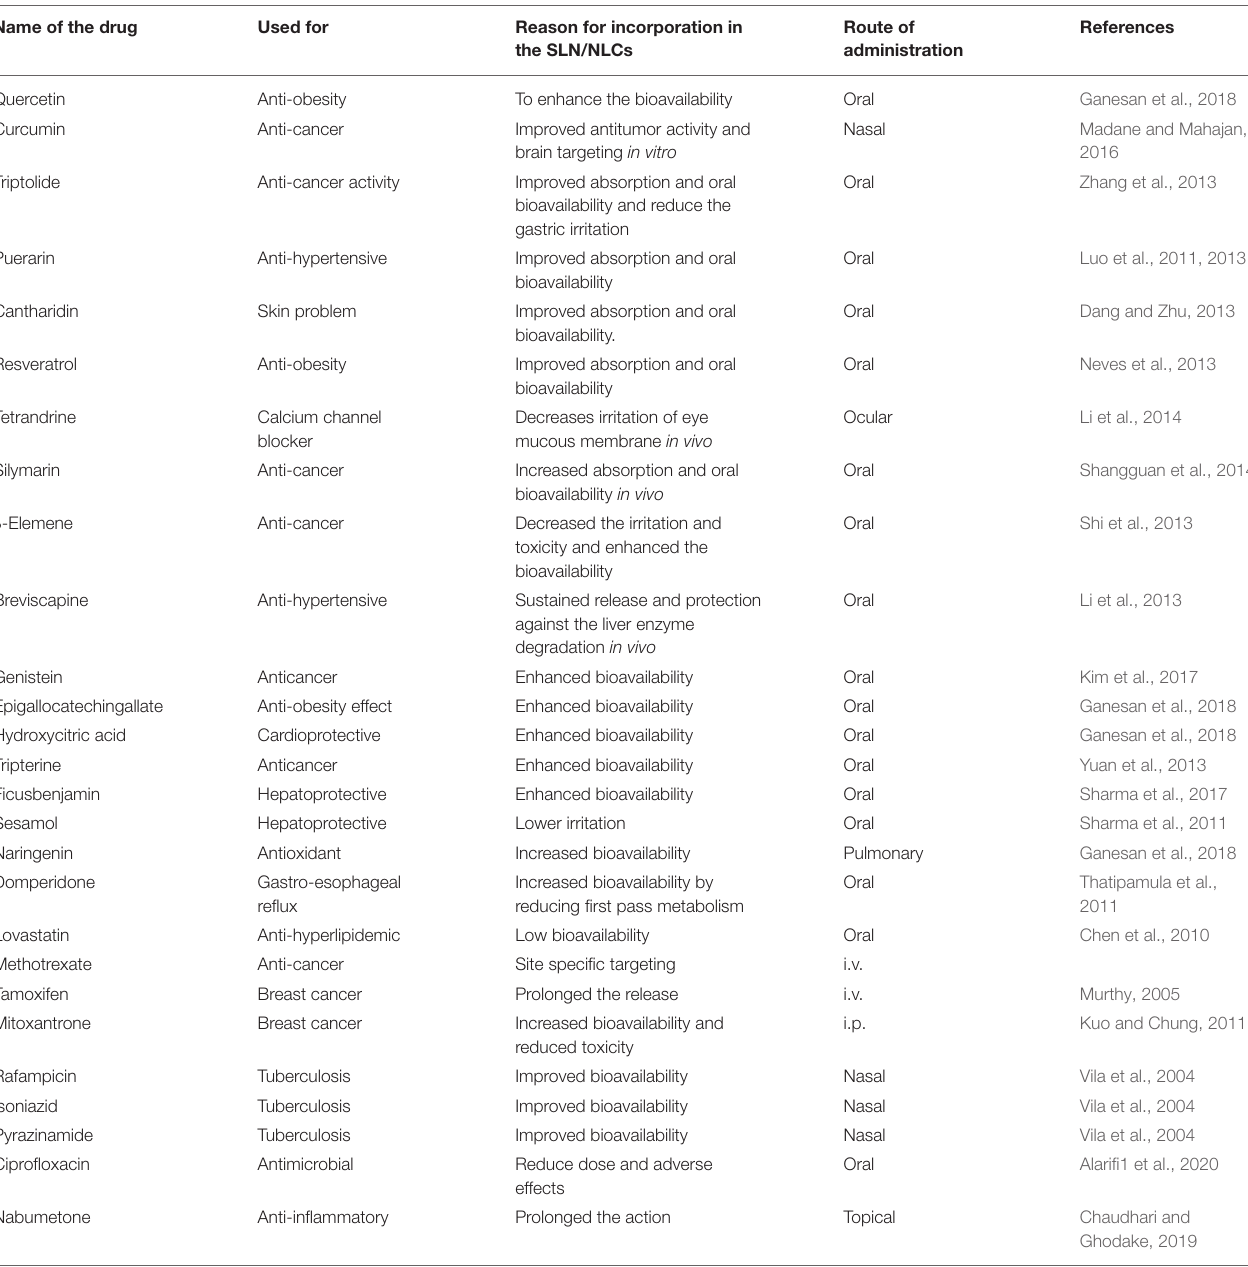
TABLE 2 | SLNs/NLCs of natural and synthetic bioactive components administered by different